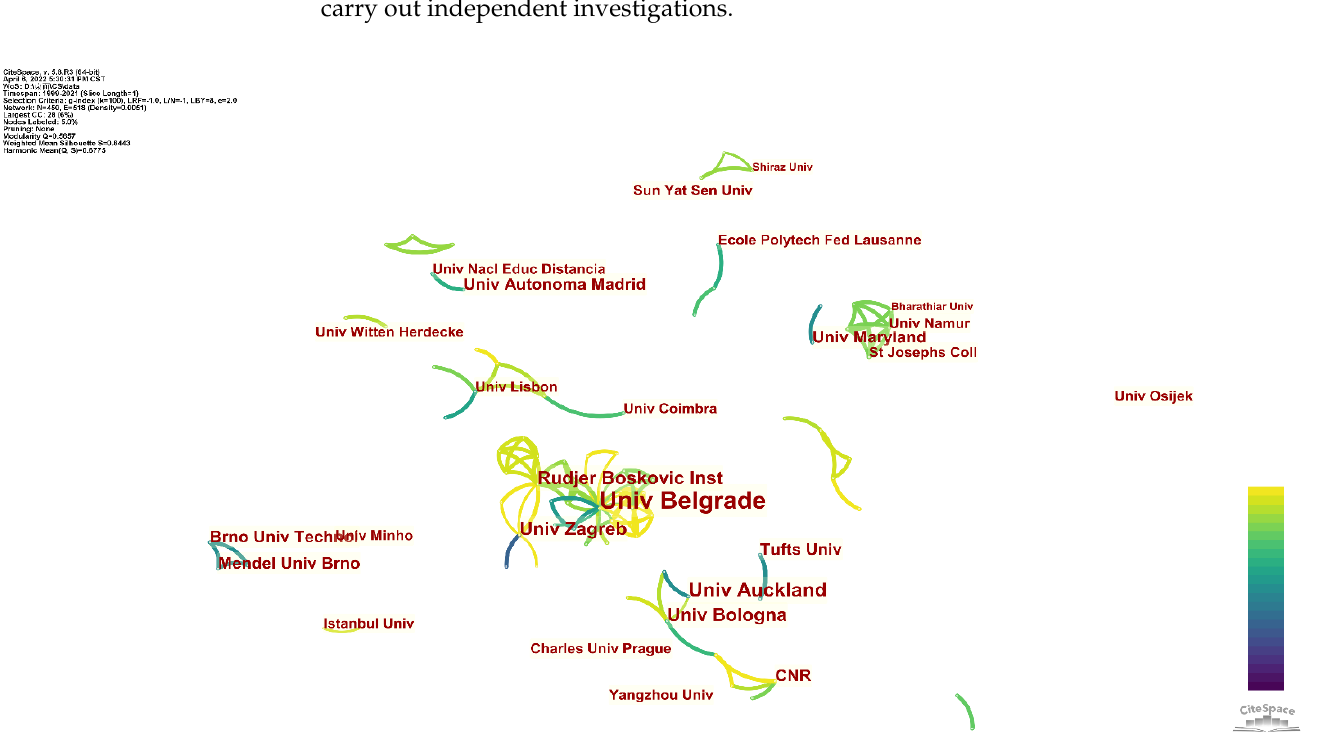
8 of 25 Figure 6. Time-zone view of geographic distribution for the evaluation of antioxidants using elec- trochemical sensors. Given that so many countries are involved in this topic, as shown in Figure 6, a col- laboration between different institutions should be frequent. Figure 7 shows the network of cooperation between different institutions. The facts proved inconsistent between this reasonable guess and reality. Collaboration between different institutions to investigate